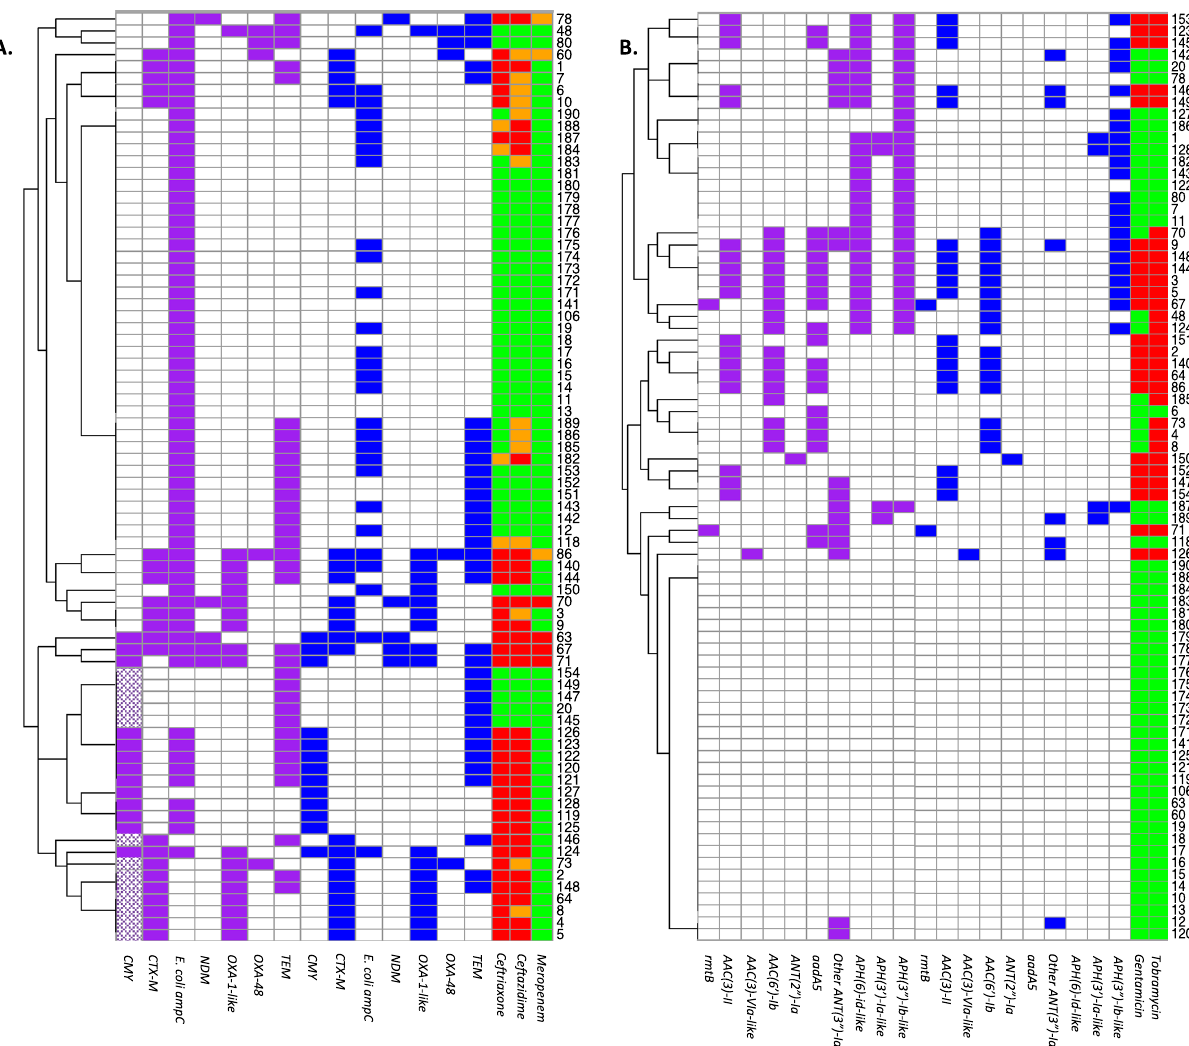
Figure 3. An overview of the different resistance mechanisms at the gene and protein level in the studied E. coli and K. pneumoniae isolates. The presence of beta-lactamase genes and proteins in the 78 E. coli and 109 K . pneumoniae isolates are shown in ( A , C ). The presence of 16S ribosomal RNA methyltransferase (16S-RMTase) and aminoglycoside modifying enzyme (AME) genes and proteins are shown in ( B , D ) for E. coli and K. pneumoniae , respectively. For each isolate, present genes were depicted in purple, proteins in blue and susceptible, intermediate and resistant phenotypes in green, orange, and red, respectively. Genes that were partly present and genes that were less than 80% similar to their reference genes were depicted with a dotted pattern. Isolates were clustered based on presence of the depicted AMR